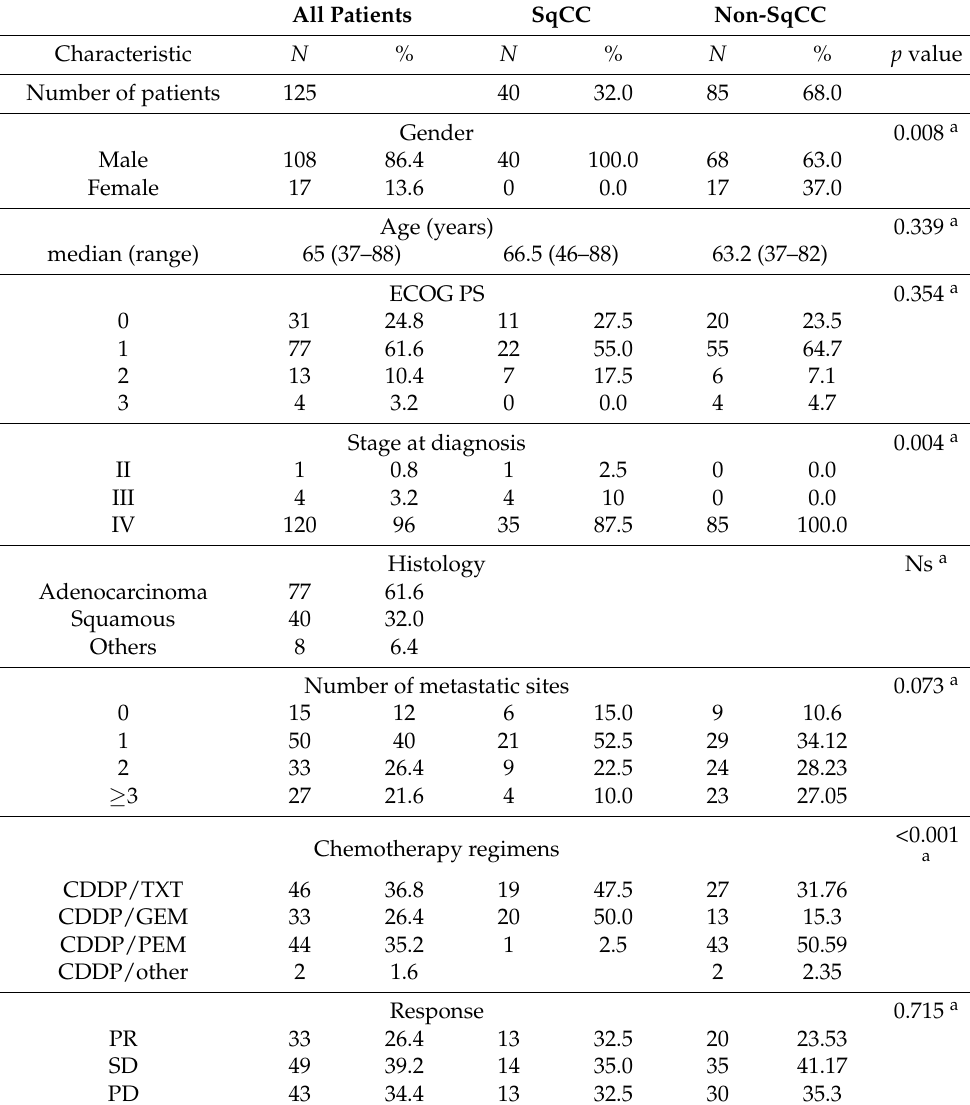
Table 1. Patients’ clinicopathological